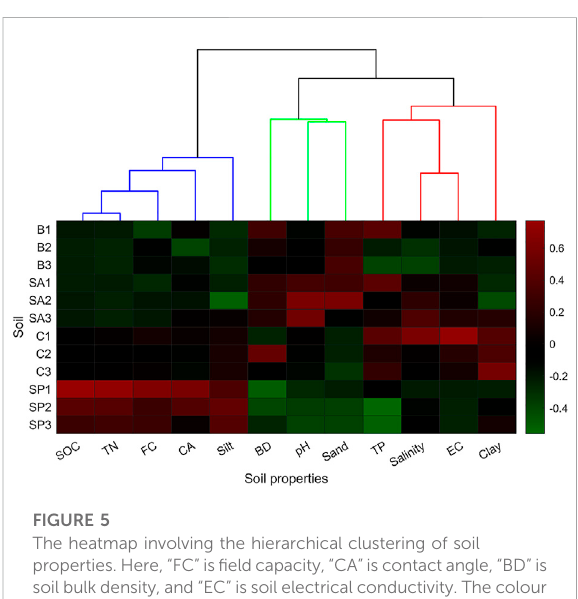
FIGURE 5 The heatmap involving the hierarchical clustering of soil properties.Here, “ FC ” is fi eldcapacity, “ CA ” iscontactangle, “ BD ” is soil bulk density, and “ EC ” is soil electrical conductivity. The colour bar represents the normalized difference of the property of eachsoilfromtheaveragevalueofthepropertyofallthesoils.The red and green blocks indicate a value higher and lower than the average, respectively. The value of one block is closer to 0, implying that the property of that soil is close to the